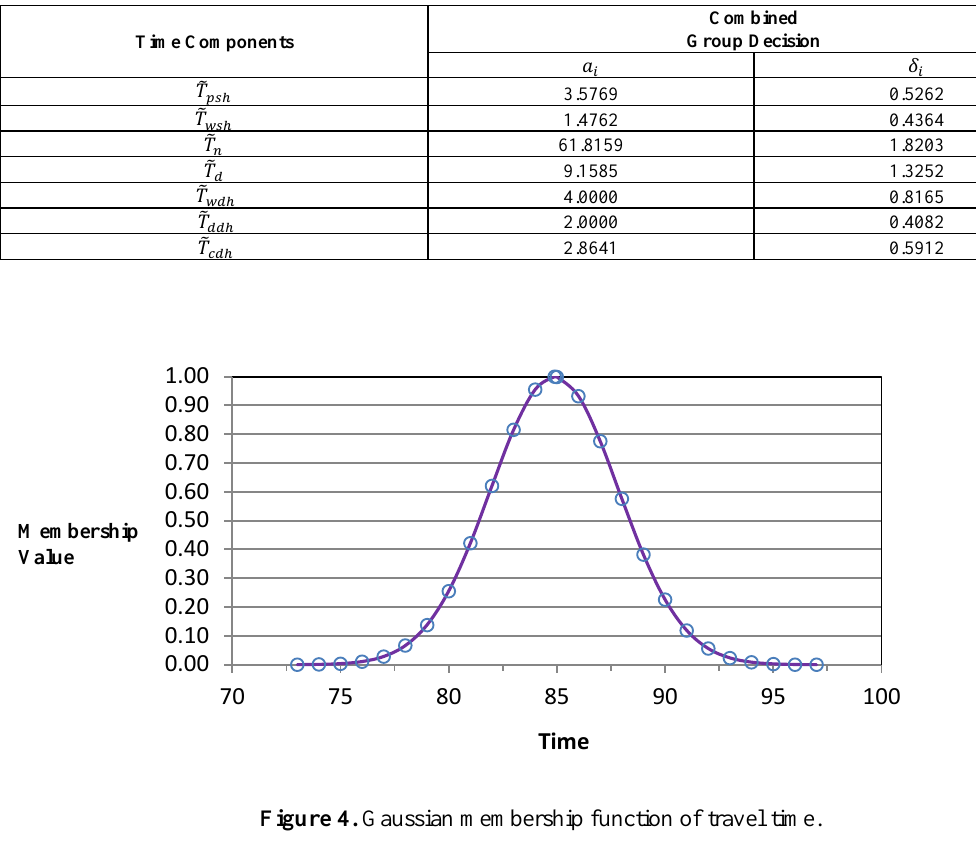
Table 5. Gaussian membership function parameters of travel time components.